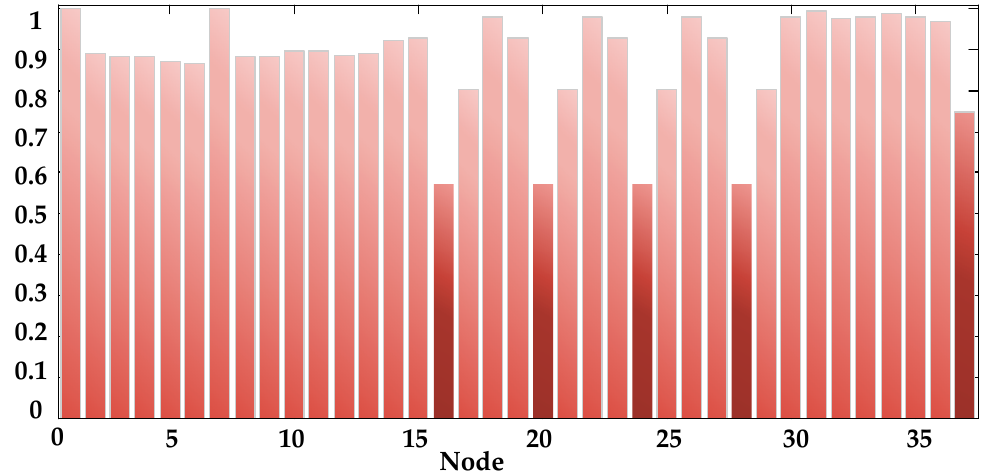
Figure 17. Reliability prediction of each piece of equipment at 439 h.